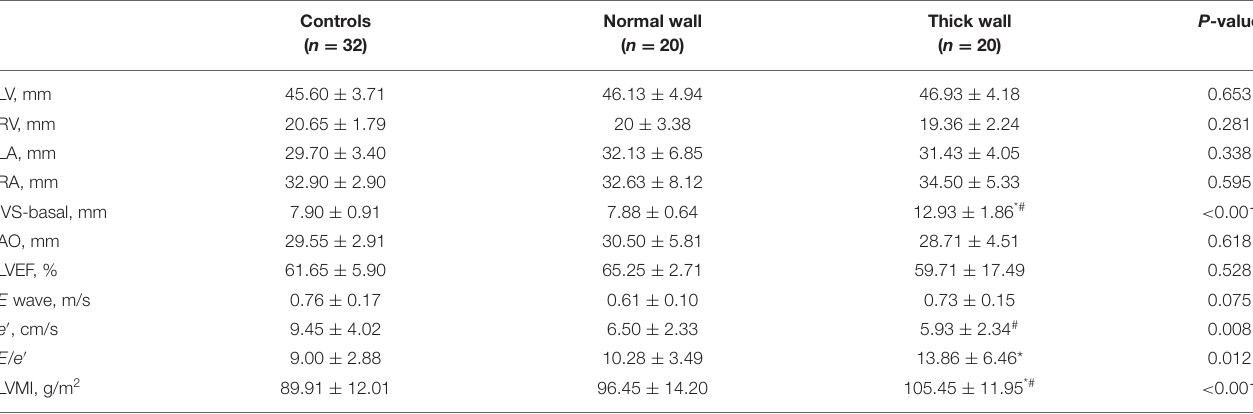
TABLE 2 | Standard echocardiographic characteristics of the study